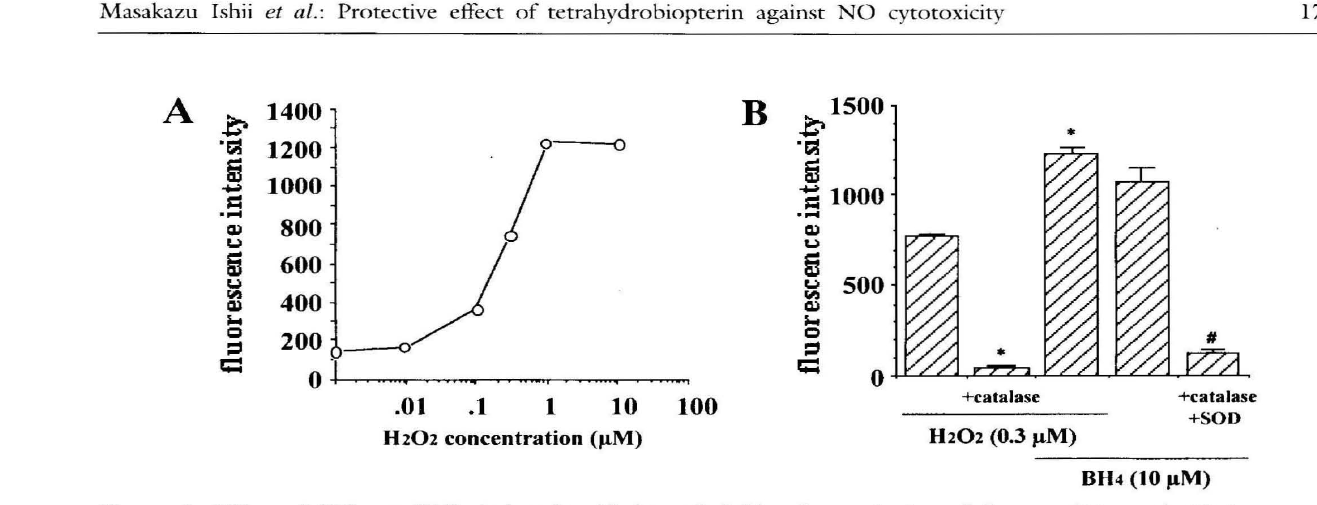
Figure 4. Effect of BH. on H 2 0 2-induced oxidation of dichlorofluorescin in cell-free conditions. A; Various con centrations of H 2 0 2 (0.1-100 J.1M) were added to the PSS containing 10 J.lM 2 ',7 '-dichlorofluorescin and 20 J.lg/ ml peroxidase. Typical results from 3 experiments are shown as the means of duplicate assays. B; Effects of catalase (100 U/ ml) and BH. (10 J.lM) on H 20, (0.3 J.lM)-induced oxidation of dichlorofluorescin and the effect of catalase (100 U / ml) plus SOD (50 U / ml) on BH. (10 J.lM)-induced oxidation of2 ',7'-dichlorofluorescin. Typical results from 3 ex periments are shown as the means ±S.E.M. of quadtuplicate assays. *Significant change in comparison to H 2 0 2 treat ment group (p < 0.05). #Significant change in comparison to BH4 alone group (p <